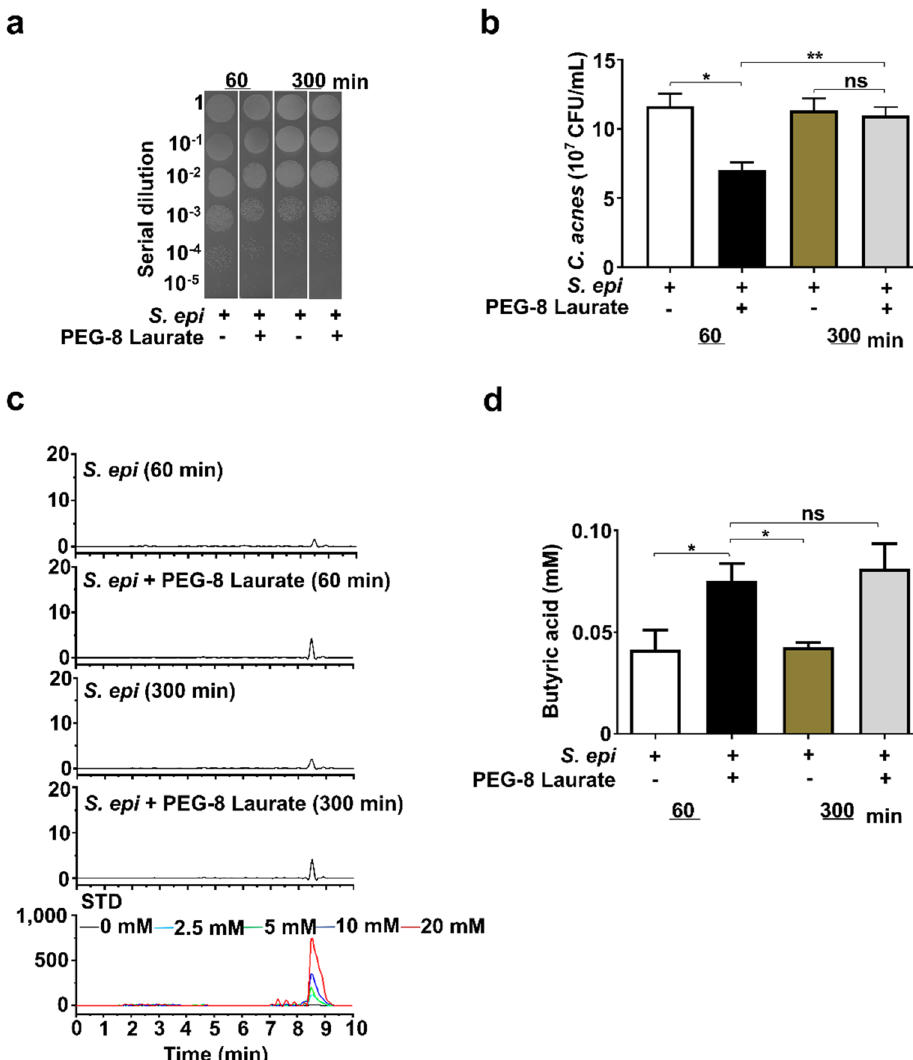
Figure 2. High production of electricity, not butyric acid, contributed to anti- C. acnes effect of S. epidermidis plus PEG-8 Laurate. ( a ) C. acnes ATCC 6919 (10 7 CFU) was incubated with media collected from the culture of S. epidermidis ( S. epi ) in the presence or absence of PEG-8 Laurate for 60 min or 300 min. C. acnes was serially diluted (1: 10 0 −1: 10 5 ) and spotted on a TSB plate for CFU counts. ( b ) The graph represents the CFU/mL of C. acnes from three independent experiments. ( c ) Representative chromatography of HPLC analysis of butyric acid in media collected from the culture of S. epidermidis in the presence or absence of PEG-8 Laurate for 60 min or 300 min. ( d ) The concentration (mM) of butyric acid was quantified based on the heights [milli-absorbance unit (mAU)] of standard (STD) peaks with concentrations of butyric acid from 0–20 mM. Data are represented as mean ± SD). * P < 0.05 (two-tailed t-tests). ns =